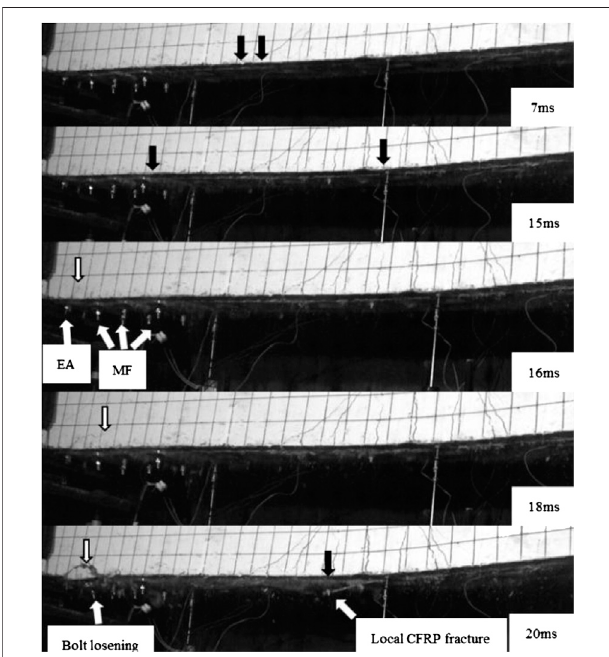
FIGURE 8 | Failure process of EA-FRP systems at impact loading (AC- D1).